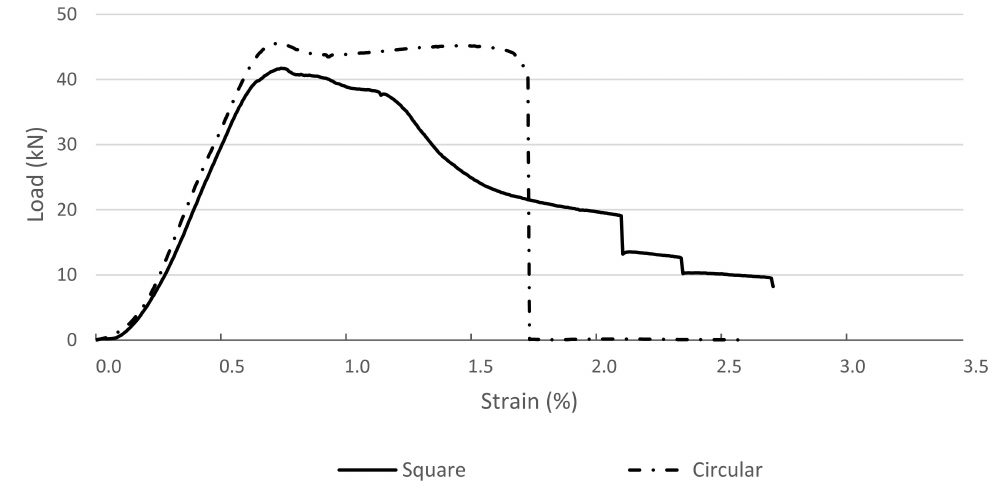
Figure 3. Load–strain relations for the tested columns of square and circular cross-sections.